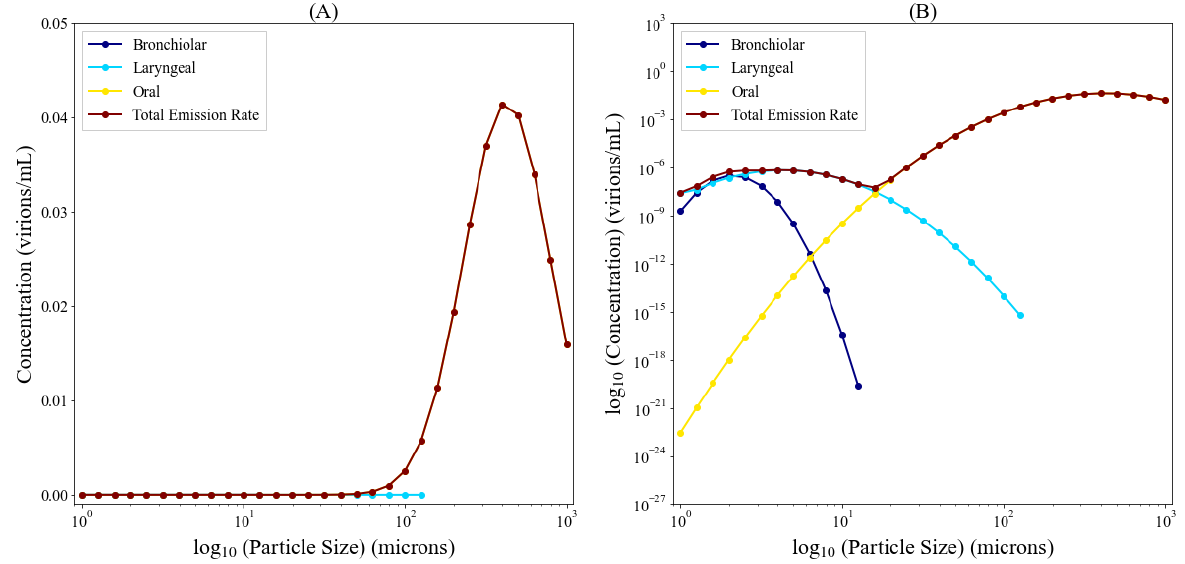
Figure 4. Contribution of emission route to the constant viral emission rate for coughing in linear-log space ( A ) and log-log space ( B ).